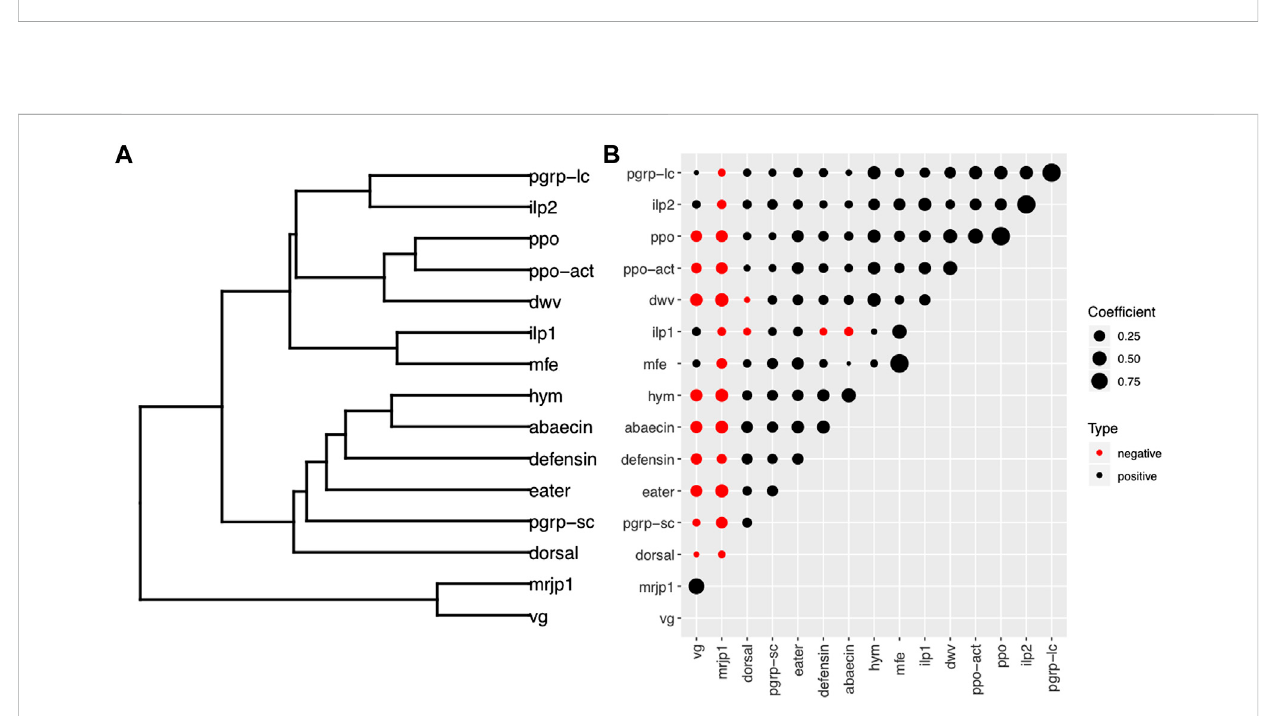
FIGURE 6 Correlations among physiological genes associated with behavior, immune genes and viruses. Correlations between expression of different genes shown by (A) dendrogram and (B) correlation matrix. The dendrogram in (A) was constructed by hierarchical clustering of a dissimilarity matrix derived from pairwise correlation coef fi cients (B) . The circle size is proportional to the correlation coef fi cient. Black circles indicate positive correlations; red circles indicate negative correlations. Hierarchical clustering based on Spearman correlations between gene targets de fi ned two major groups. The fi rst cluster consisted of vg and mrjp1 , whose expression is characteristically elevated in nurse bees. The physiological genes associated with foraging, immune genes and DWV formed the second